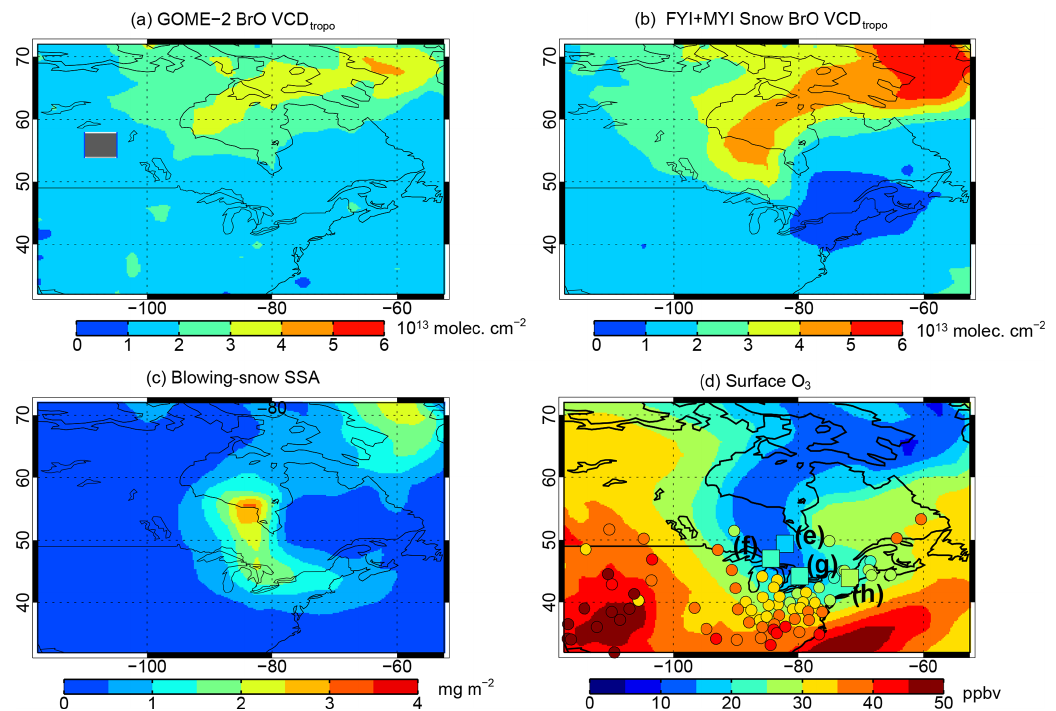
Figure 11. Mean 5–9 April 2007 VCD tropo for (a) GOME-2 and (b) the GEOS-Chem FYI+MYI Snow simulation. Mean 5–9 April 2007 (c) blowing-snow SSA burden and (d) surface O 3 mixing ratios for 5–9 April 2007 from the GEOS-Chem FYI+MYI Snow simulation. Surface O 3 observations are shown as color-coded symbols in panel (d) , with the squares corresponding to the sub-Arctic sites from Fig. 8. The letter numbering for (e) – (h) corresponds to the panel numbers in Fig.